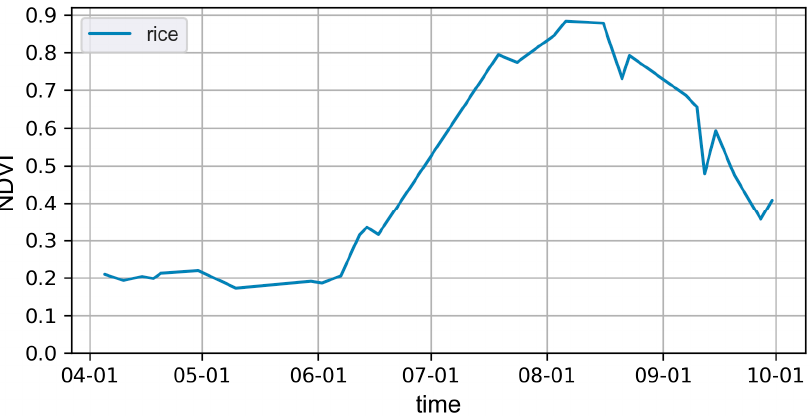
Figure 2. NDVI of rice in the study area between April and September 2020. (3) The bimonthly NDVI map is cut into 100 images of 1098 × 1098 pixels, and 58 of